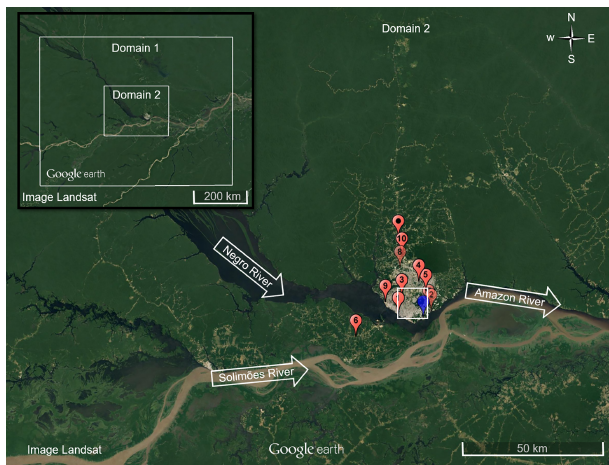
Figure 1. Satellite image of the land cover of the study region. Man- aus – located at 3.1 ◦ S, 60.0 ◦ W – is visible in the center. Power plants (red markers) and an oil refinery (blue marker) are indicated (cf. Table 2). The white box represents the region of 10km × 10km that is used for the analyses in Figs. 2, 3 (black box), and 4. The Solimões River, running from the west to the east, is visible in brown. This river has turbid waters laden with sediment. The Ne- gro River is a main tributary. It is visible in black, running from the northwest to southeast. The named Amazon River (Portuguese) is the confluence of these two flows near Manaus. In the top left of the figure, the two grids used in the modeling are shown. The outer grid has corners of 5.10 ◦ S, 63.14 ◦ W and 0.73 ◦ S, 57.48 ◦ W. The inner grid has corners of 3.63 ◦ S, 61.26 ◦ W and 2.16 ◦ S, 59.36 ◦ W. The latitude–longitude corners of the main panel are the same as the inner